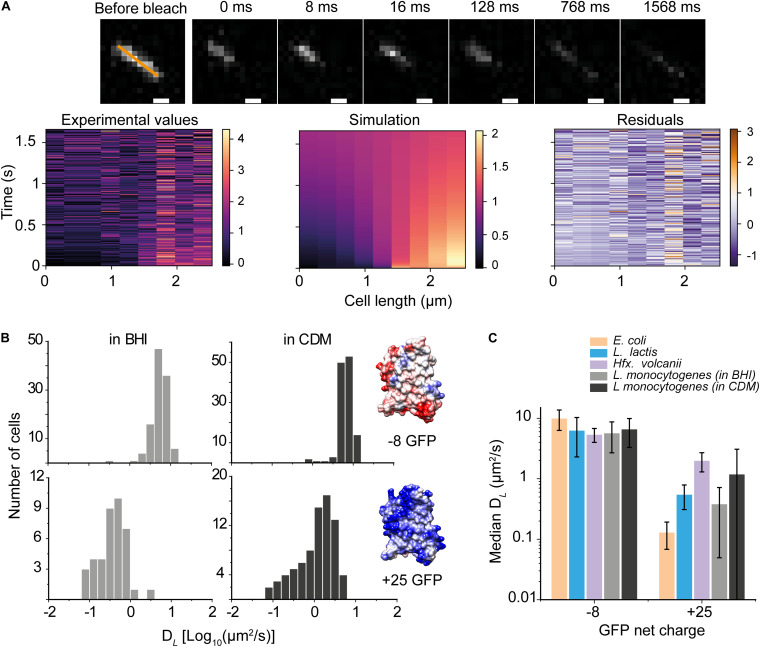
Diffusion of anionic and cationic GFP in Listeria monocytogenes. (A) (top) Recovery of +25 GFP fluorescence, corresponding to DL of 0.81 ± 0.042 μm2/s. (bottom) The fluorescent intensity along the orange line is shown as a function of time for the experimental data (left) and the one-dimensional heat-equation simulation (middle), and the residuals of the data (right). (B) Histograms of diffusion coefficients of –8 GFP (top) and +25 GFP (bottom) of cells grown in BHI and CDM as well as structural models the surface-modified GFP variants; the colors display the surface charge. The models are based on the structure of super-folder GFP (PDBID: 2B3P), and the images were created using UCSF Chimera (Pettersen et al., 2004). Poisson-Boltzmann electrostatics calculations and evaluations were done by PDB2PQR and APBS packages (Baker et al., 2001; Dolinsky et al., 2004). (C) The diffusion coefficient of –8 and +25 GFP in L. monocytogenes, and –7 and +25 GFP in E. coli, L. lactis, and Hfx. volcanii; the latter have been taken from Schavemaker et al. (2017). The bars indicate medians and the error bars show the interquartile range.